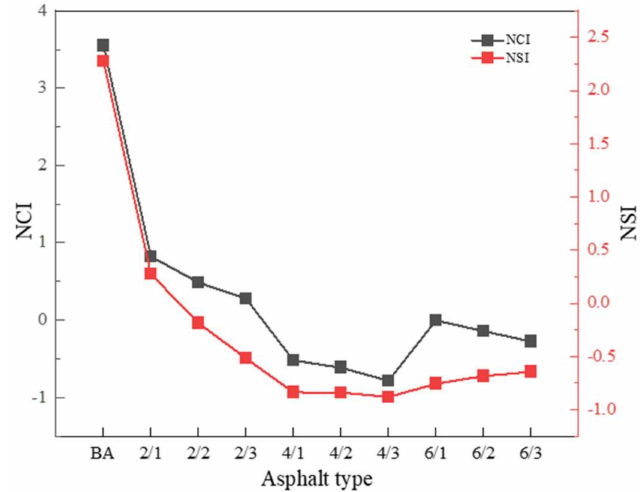
Figure 12. Normalized carbonyl index ( NCI ) and normalized sulfoxide index ( NSI ) of different